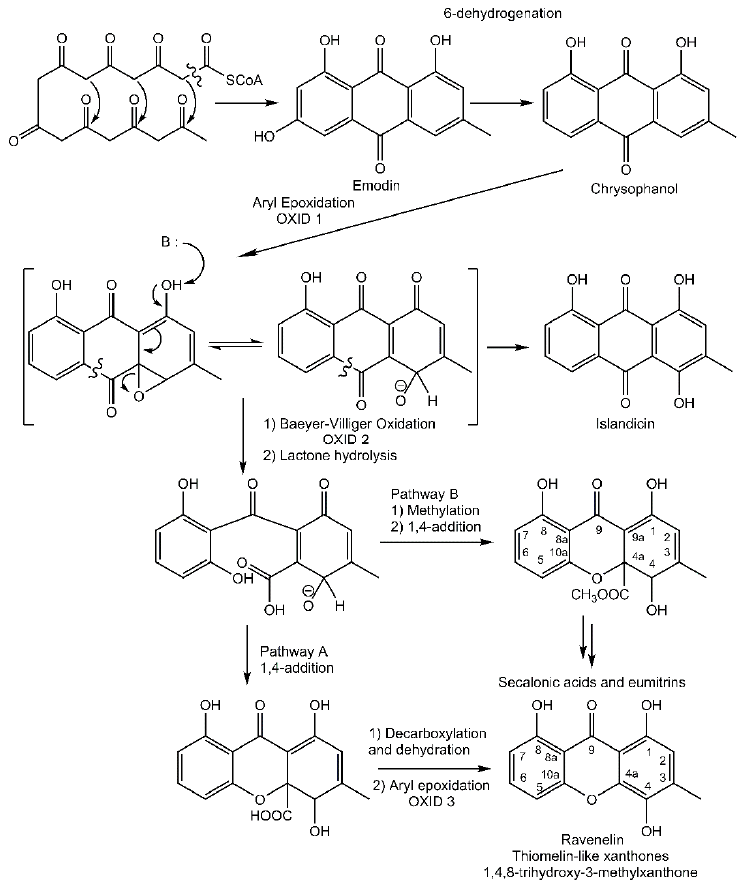
Figure 2. Proposed biosynthetic pathway for thiomelin-type lichen xanthones. Adapted from [12].